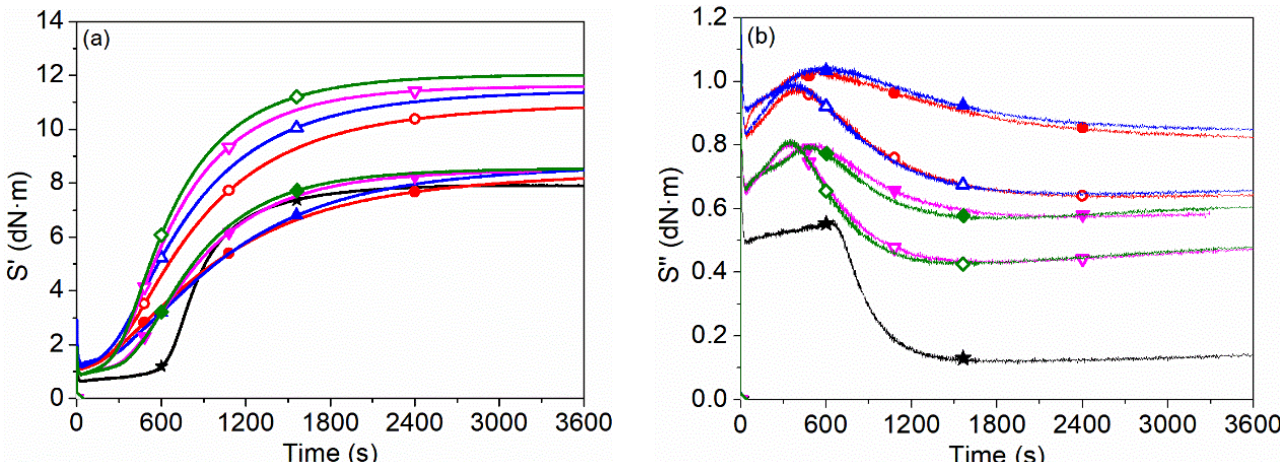
Figure 7. Curing curves of ( a ) elastic torque (S ′ ) and ( b ) viscous torque (S ″ ) for (K-)illite filled SBR composites. The solid represents illite/SBR, while the hollow represents K-illite/SBR. The red, blue, magenta, and olive lines indicate (K-)illite-1, (K-)illite-2, (K-)illite-3 and (K-)illite-4 filled SBR composites, respectively. The black line indicates unfilled SBR composite. Table 5. Cure characteristics of illite/SBR and K-illite/SBR composites with different illite particle sizes.